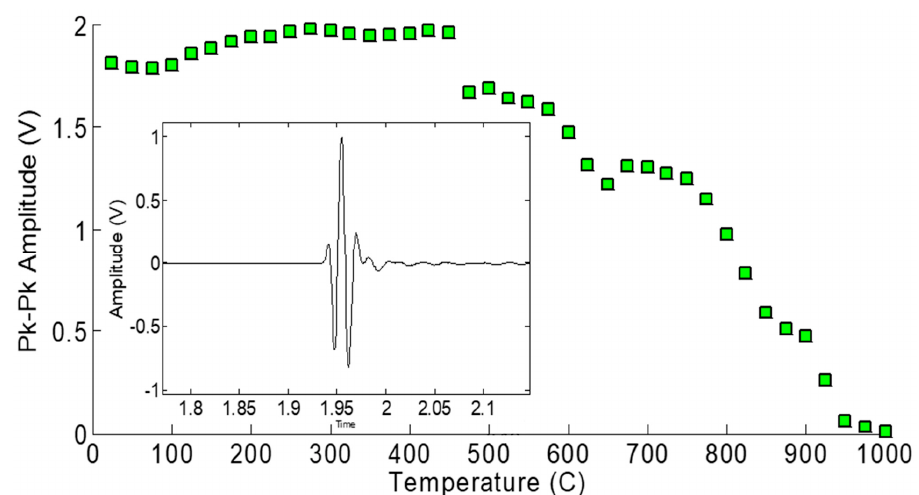
Figure6. Temperaturedependenceofpulse-echoamplitudeforPZT / Bi 4 Ti 3 O 12 piezocompositespray-on transducers deposited on steel cylinders [29].